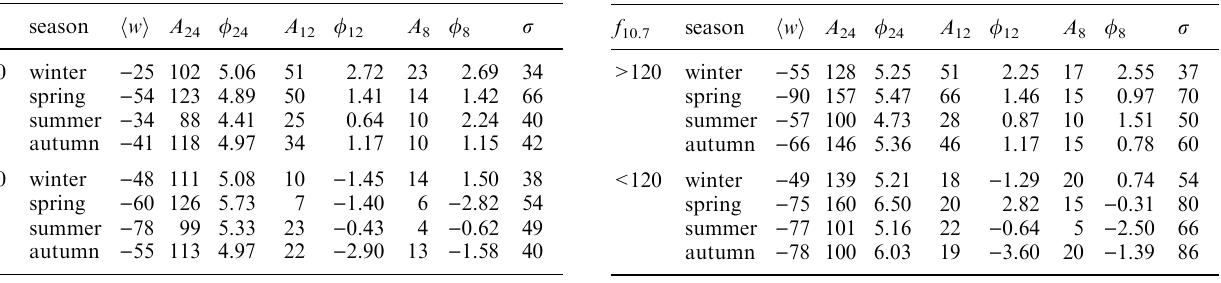
Table 12. Harmonic decomposition at 330 km height